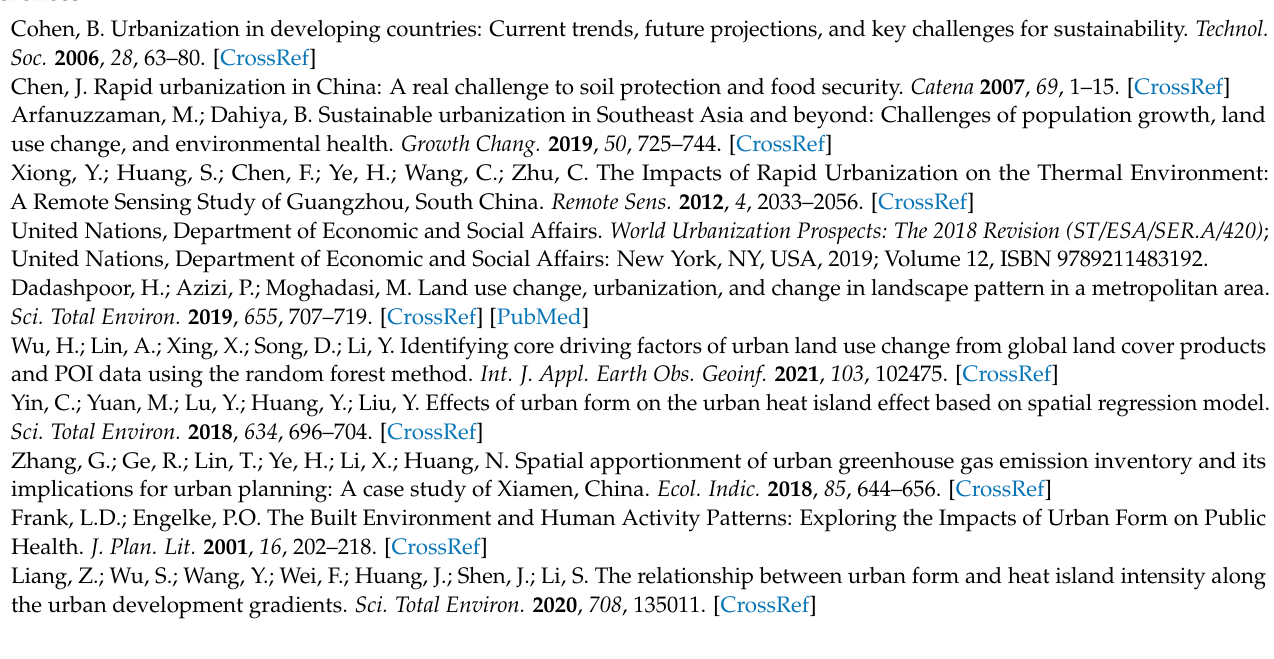
results in different scales. Figure S2: The extracted areas using the quantile-based approach with 3D (a) and 2D (b) indicators in Beijing. Figure S3: The road density curves of all cities. Figure S4: Illustration of the road density curve change in representative cities with different road distribution patterns. Figure S5: Satellite images of six